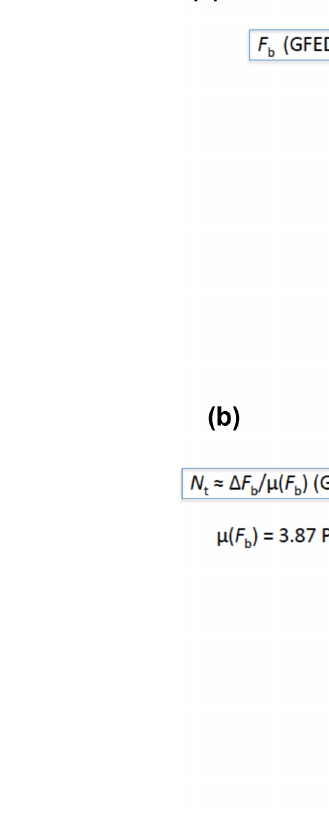
Figure 1. Schematic of the analysis of global fire–temperature relationships for the (a) satellite and (b) pre-industrial eras. F b : biomass burning flux; T land : global mean land temperature; T : global mean temperature; W : global land carbon storage; NPP: global net primary production; W / NPP: residence time of land carbon; AF: airborne fraction; 2.12: conversion factor from ppm to PgC; S : climate sensitivity; C : atmospheric CO 2 mole fraction; N t : normalized anomalies of charcoal data; (cid:49)F b : biomass burning flux anomalies; µ ( F b ): mean biomass burning flux. See text for sources of temperature